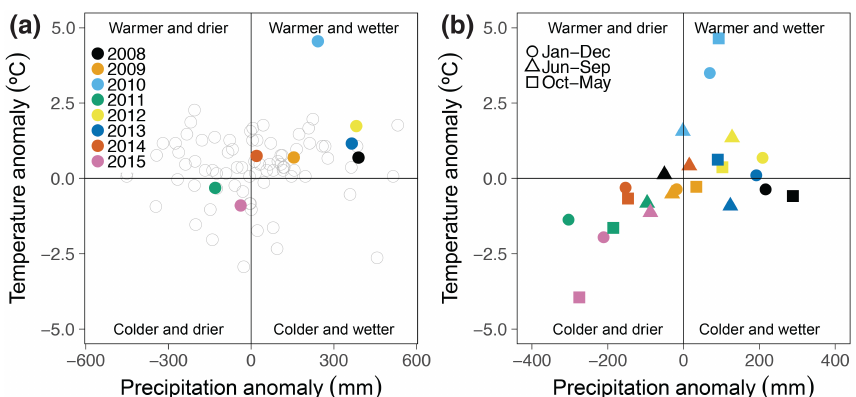
Figure 2. (a) Annual temperature ( ◦ C) and precipitation (mm) anomalies of the analysed years (2008–2015) compared to the 1866–2007 time series shown as empty circles (Cappelen, 2016), and (b) within the 2008–2015 period including annual (January to December), warm season (July to September) and cold season (October to May)